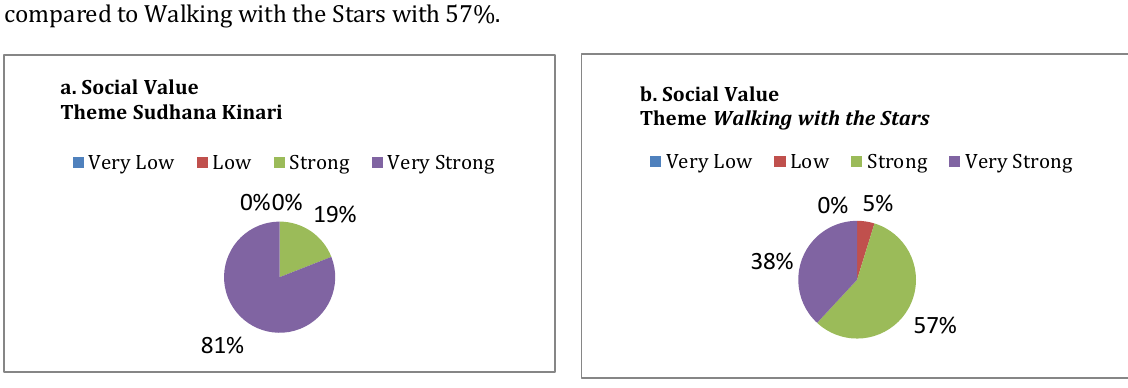
Fig. 4 Social Value Theme 1; a Sudhana Kinari , b Walking with the